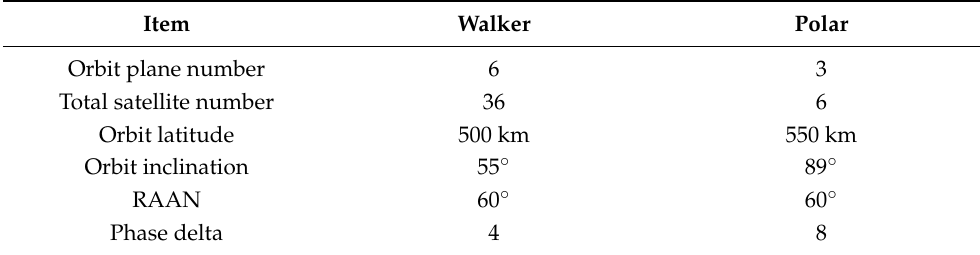
Table 3. DCS constellation design.